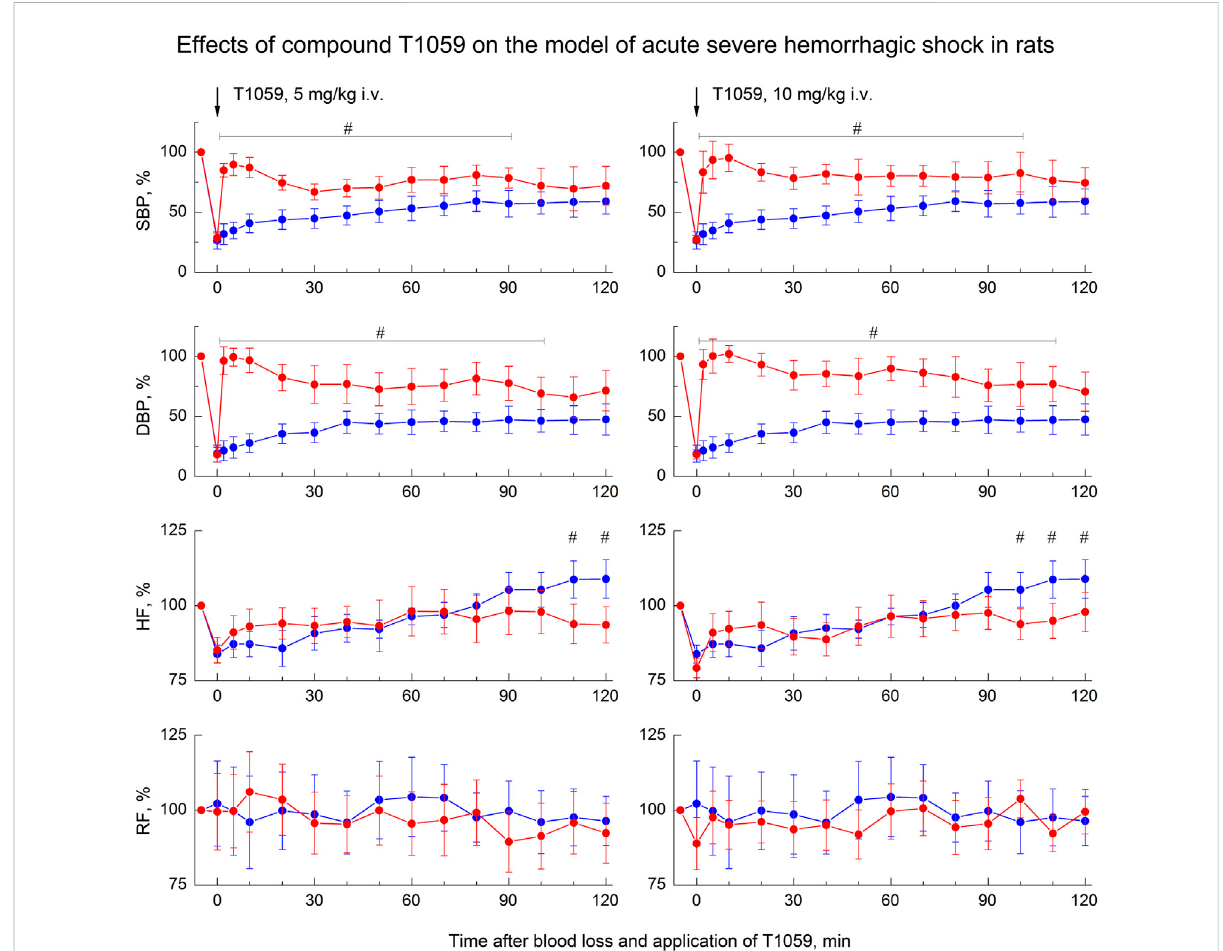
FIGURE 3 Effect of compound T1059 with a single i.v. injection at doses of 5 mg/kg (left) and 10 mg/kg (right) on hemodynamics and external respiration of Wistar rats at an early stage of acute severe hemorrhagic shock. Red symbols and lines are indicators of T1059-treated rats ( n = 12 – 15 per point), blue symbols and lines are indicators of untreated rats ( n = 10 – 28). Data are normalized to the original values of indicators of animals and presented as percentage. Graphical deviations correspond to SD. # - signi fi cantly different indicators in untreated vs. T1059-treated rats (5 mg/kg, SBP: p = 0.00002, p < 0.00001, p = 0.00004, p = 0.00073, p = 0.00462, p = 0.00218, p = 0.02964, p = 0.00871, p = 0.01053, p = 0.00932, p = 0.03817, respectively; DBP: p < 0.00001, p < 0.00001, p < 0.00001, p = 0.00006, p = 0.00175, p = 0.00322, p = 0.00789, p = 0.00648, p = 0.00470, p = 0.00091, p =0.00467, p =0,02306, respectively; HF: p =0.03715, p =0.01872,respectively. 10 mg/kg, SBP: p =0.00027, p =0.00008, p < 0.00001, p = 0.00036, p = 0.00084, p = 0.00053, p = 0.00779, p = 0.00092, p = 0.00415, p = 0.01930, p = 0.04706, p = 0.03021, respectively; DBP: p